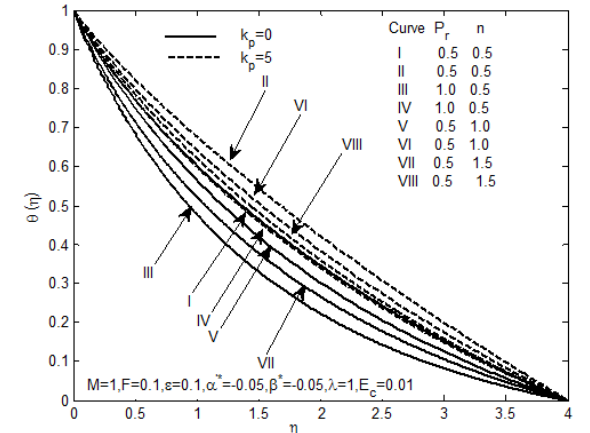
Figure 9: Temperature profiles (PHF case)